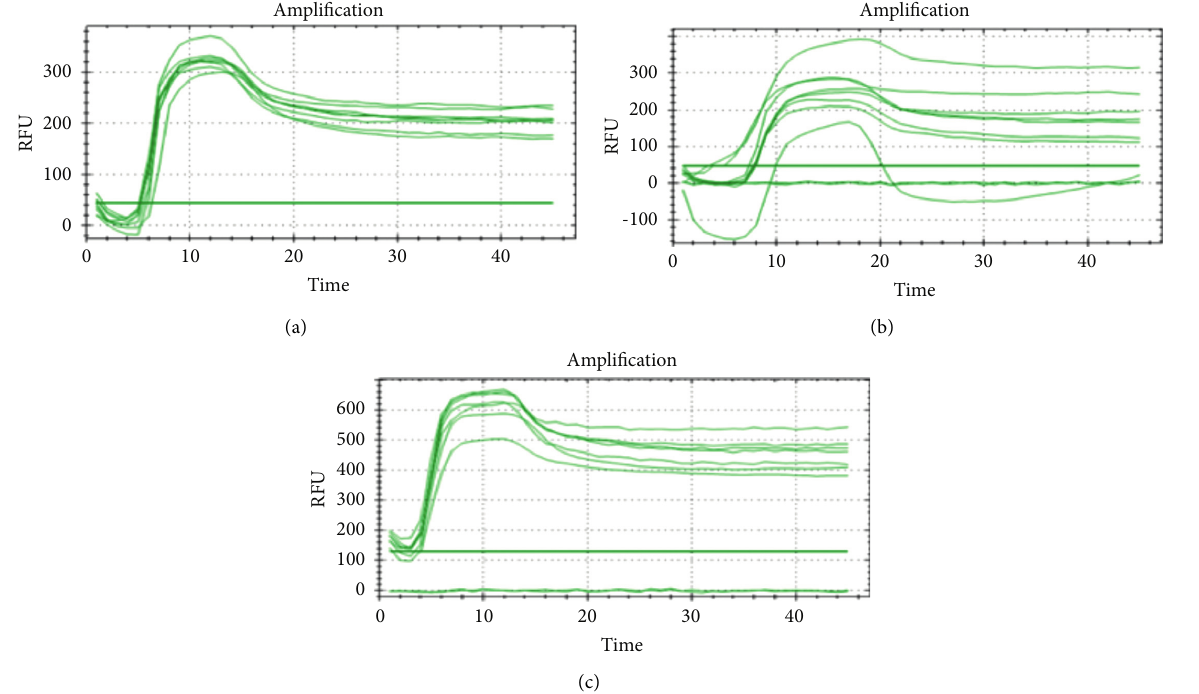
Figure 6: Time course detection of DNA sample stained on different surfaces in day 45 by qLAMP. (a) � brick, (b) � cloth, and (c)